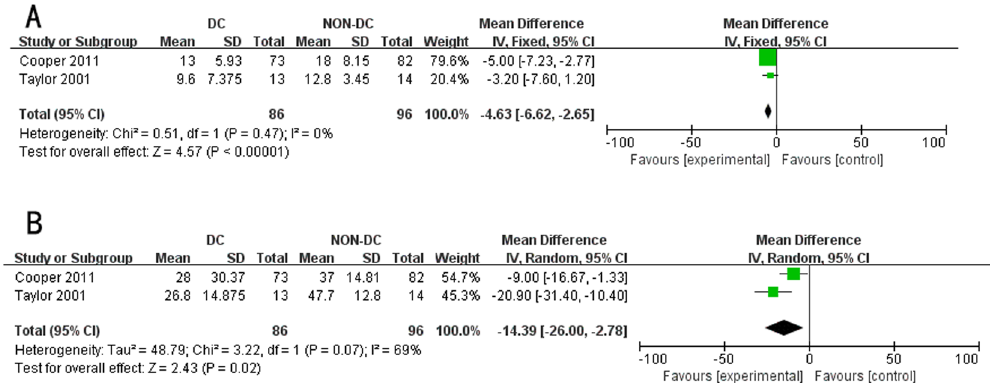
Figure 5. Forest plots for the effect of DC versus NON-DC on length of ICU and hospital stay. ( A ) length of ICU stay; ( B ) Length of hospital stay. DC, Decompressive Craniectomy; ICU, intensive care unit.